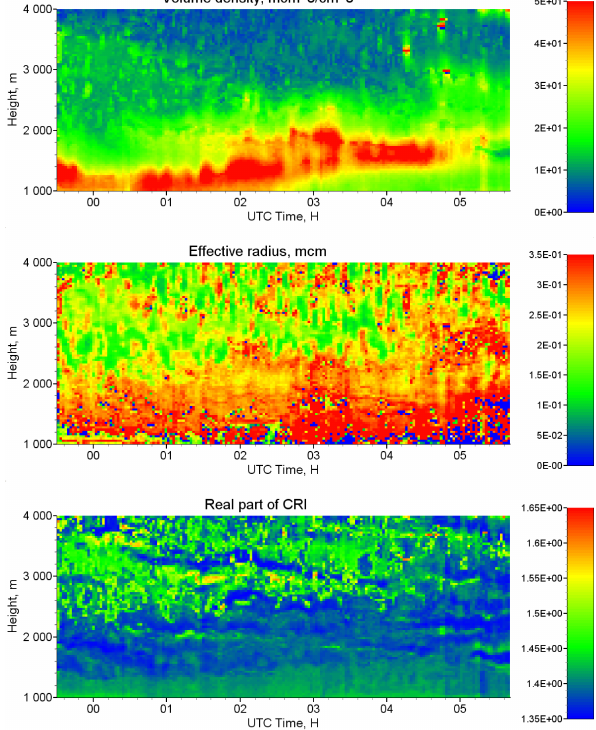
Figure 18. Height–time distribution of volume density, effective ra- dius and the real part of the refractive index retrieved from 3 β + 2 α measurements on 27